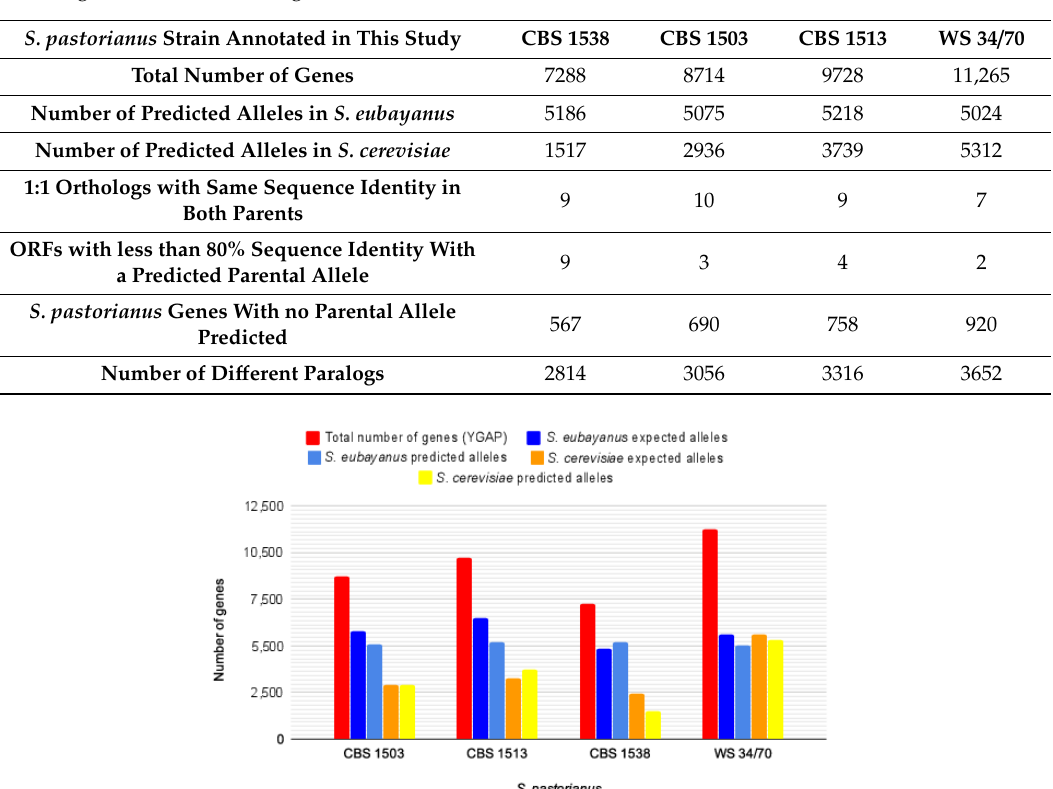
Table 2. HybridMine predictions of the total numbers of S. cerevisiae- like and S. eubayanus -like alleles among the total number of genes.